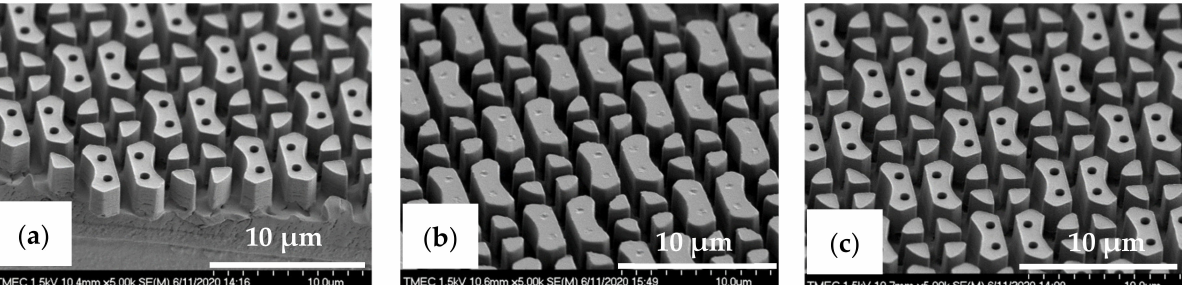
Figure 15. Tilted-view SEM images of C-RESS micro-structure (pattern design: size: 1.5 µ m, space: 0.5 µ m, height: 2.5 µ m) replicated by R2P NIL process ( a ) imprint on PC foil with resin A (C-RESS-A), and ( b , c ) imprints on PC foil with resin B (C-RESS-B).